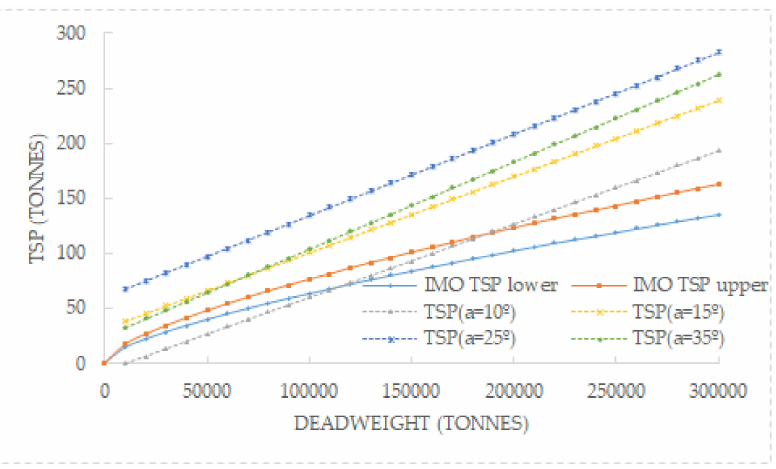
Figure 8. IMO TSP limits and calculated TSP as per Model 4 for different rudder